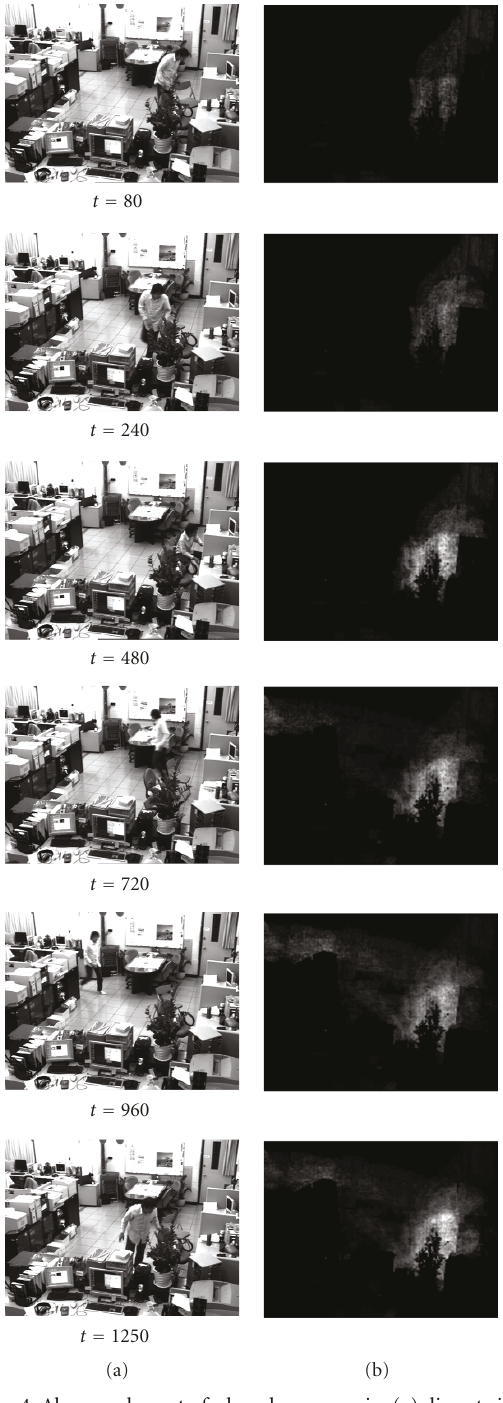
Figure 5: Abnormal event of a fighting scenario: (a) discrete image frames in the sequence; (b) corresponding energy